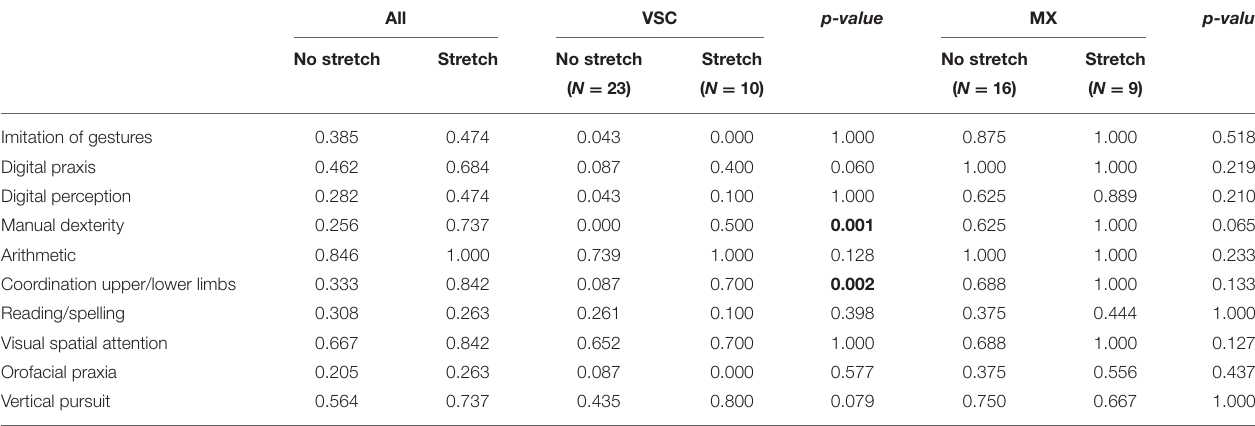
TABLE 4 | Frequency of impairment for the 10 most important predictors selected by the Logic Forest classifier, according to phasic stretch reflex status, and subtype of dyspraxia.